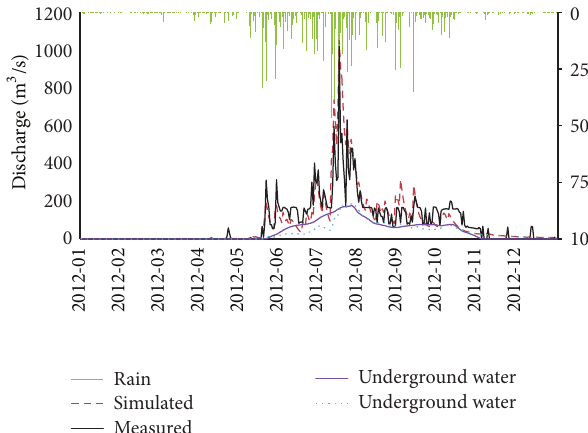
Figure 9: XAJ model validation phase (2010). Measured and simu- lated discharge, the groundwater runoff separated from the hydro- graph and calculated by Xin’anjiang model, and catchment average rainfall time series.